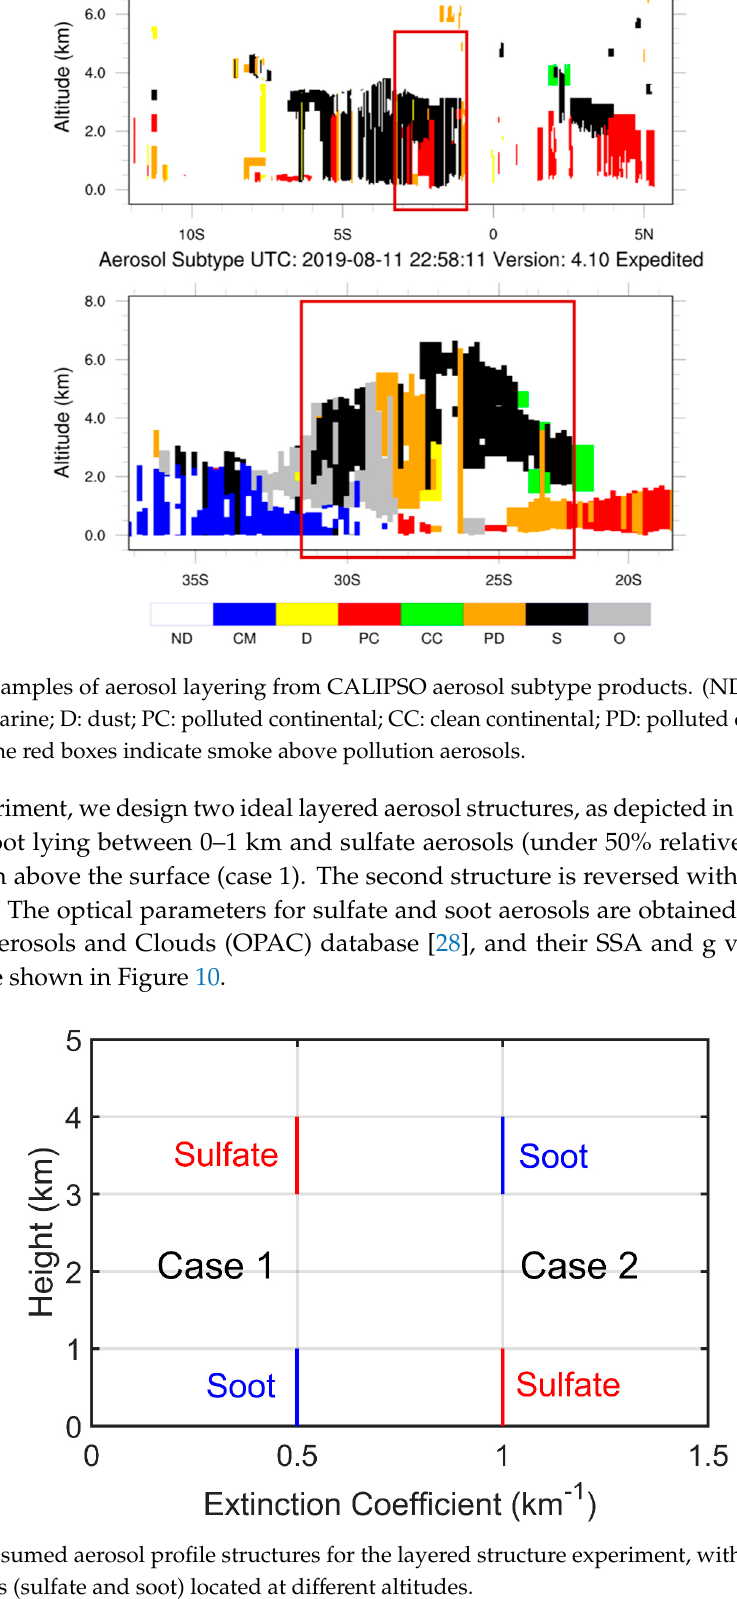
Figure 10. Spectral dependence of single scattering albedo ( a ) and asymmetry factor ( b ) for soot and sulfate (50% humidity) obtained from the OPAC database. In both cases, the optical depth fractions for soot and sulfate are 10% and 90%, respectively. We first calculate the TOA reflectance at nadir view for these two cases, and then use these TOA reflectances to retrieve AOD, assuming an exponential profile with a scale height of 2 km. The SSA and g used are equivalent values, assuming the external mixing of the two aerosol components. Figure 11 shows the retrieved AOD error, assuming a mixed exponential profile relative to the two layered cases. First, it is seen that the AOD errors are reversed for the two cases, i.e., errors are positive when soot lies above sulfate and negative when soot lies below sulfate. The explanation of this phenomenon could be that in case 1, sulfate above blocks solar radiation from reaching the black carbon layer, thus reducing its absorptivity and increases TOA reflectance, whereas, for case 2, scattering aerosol underneath will act as a bright surface, which enhances black carbon absorption and thus reduces the TOA reflectance compared to the mixed case. The errors are also quite large and asymmetric, with larger errors for the soot above sulfate case. For case 2, when soot lies above, errors